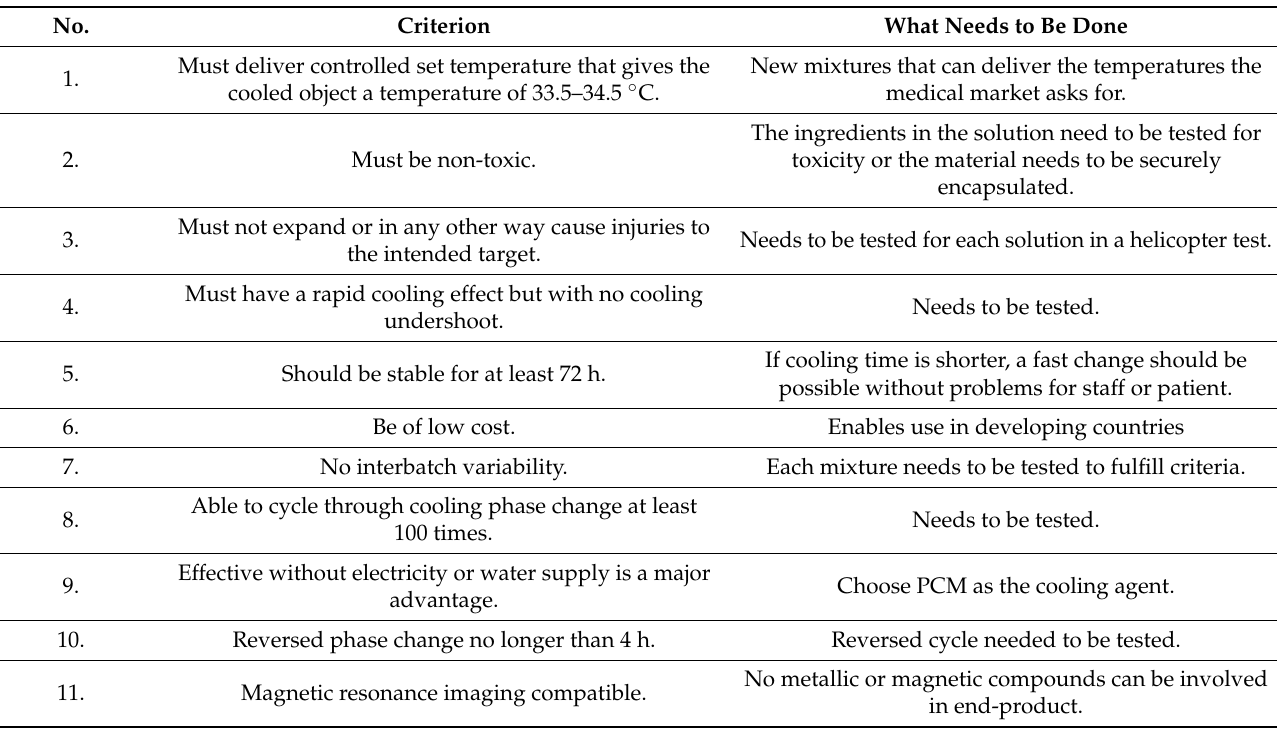
Table 1. PCM criteria needed for medical applications such as cooling of infants and children suffering from oxygen deprivation. No.